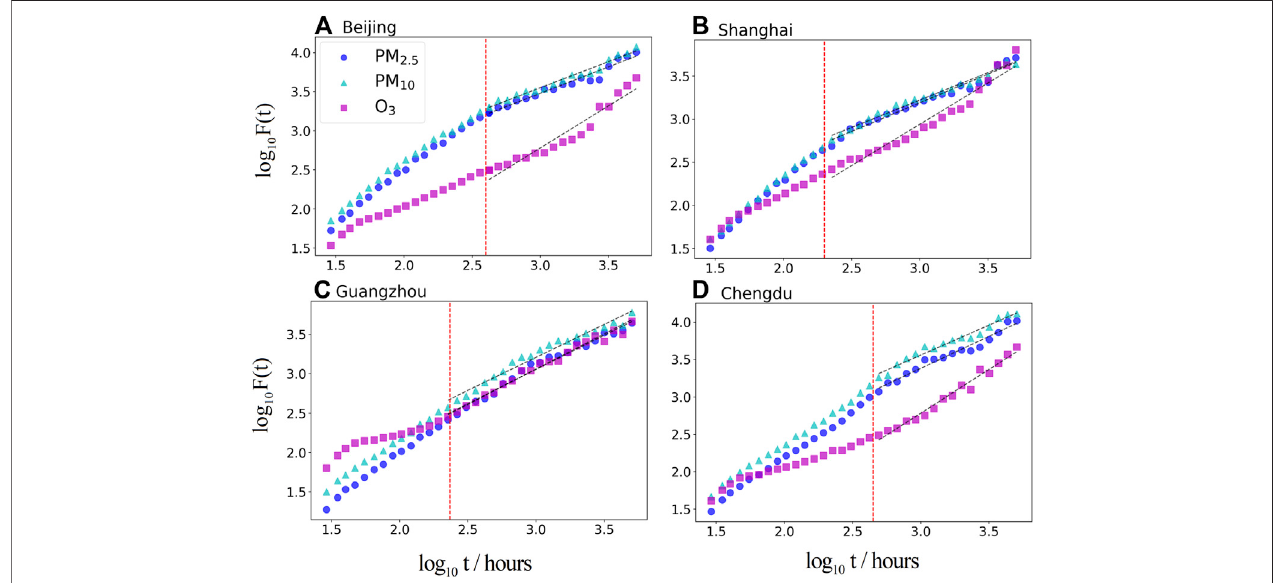
FIGURE4| (coloronline)TheDFAanalysisinwinterfor (A) Beijing, (B) Shanghai, (C) Guangzhouand (D) Chengdu.Blackdashedlinesare fi ttedpower-lawcurves. Red dashed lines represents the location of the crossover point s x of AR (1) processes with different parameters a .